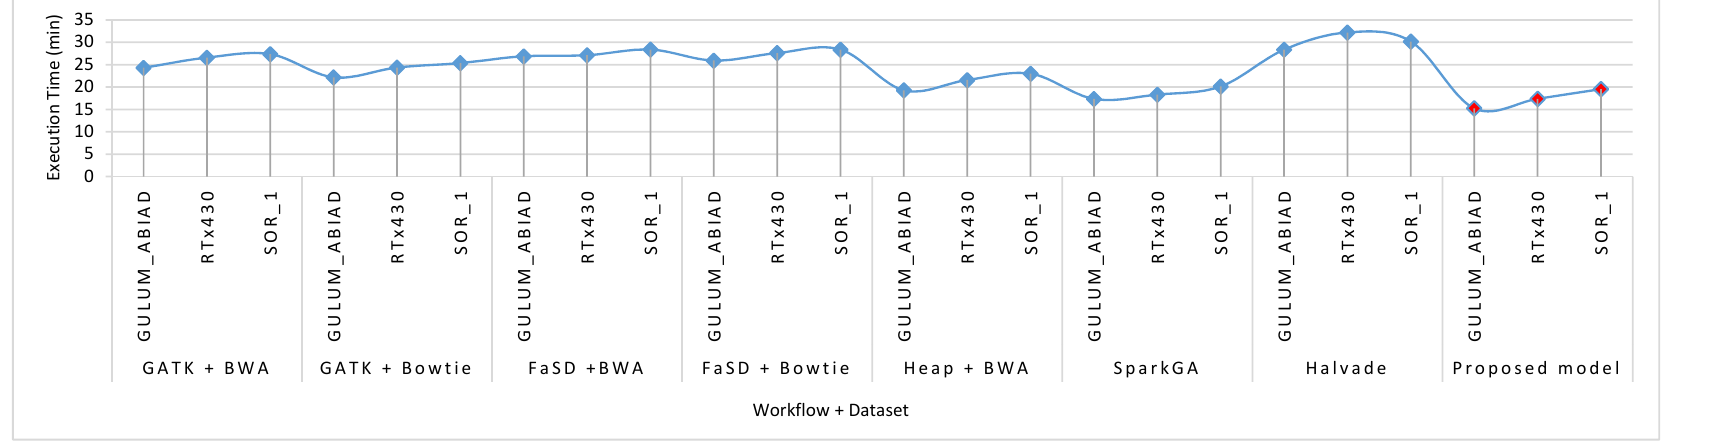
b. 8 Nodes Cluster Execution Time Analysis on Sorghum Datasets